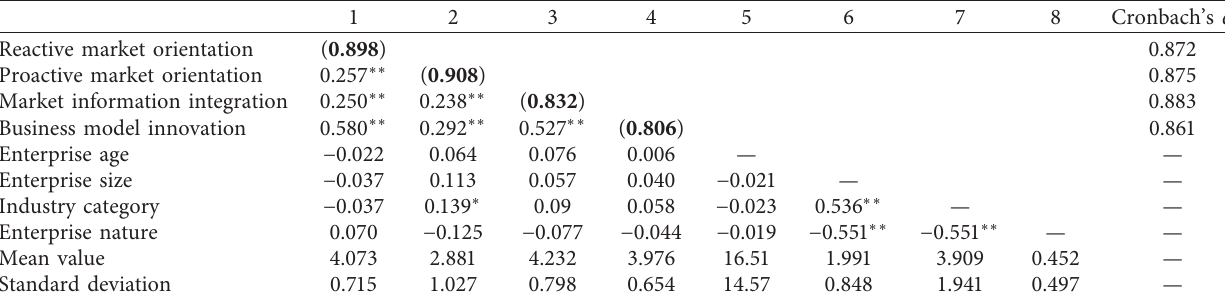
Table 1: Correlation